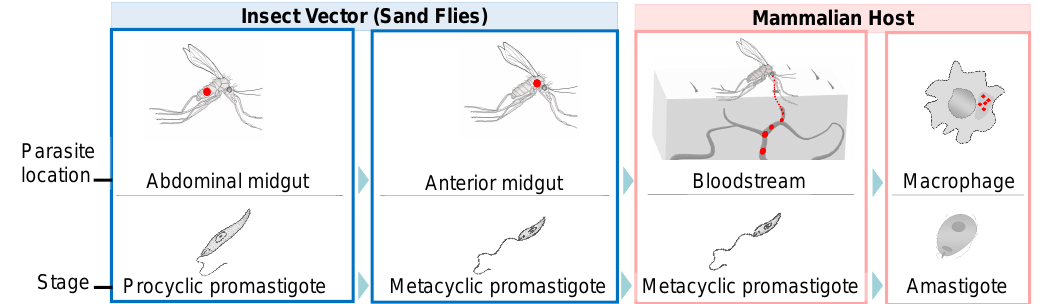
Figure1. Majorstagesin Leishmania parasitedi ff erentiation.Duringthe Leishmania lifecycle, theparasites transit from phlebotomine sand fly vectors to mammalian vertebrate hosts. In the invertebrate host, Leishmania spp. adopts two di ff erent stages. The procyclic promastigotes proliferate in the insect abdominal midgut, progressively becoming metacyclic promastigotes migrating toward the anterior midgut. Next, the parasites are transmitted to mammalian hosts during a blood meal. Once in the vertebrate host, the parasites enter phagocytes and transform into intracellular amastigotes. The amastigotes can survive and proliferate inside the phagolysosome, eventually destroying the cell host, infecting new mammalian cells, and restarting an infection round during a new insect bite. Red dots indicate location of